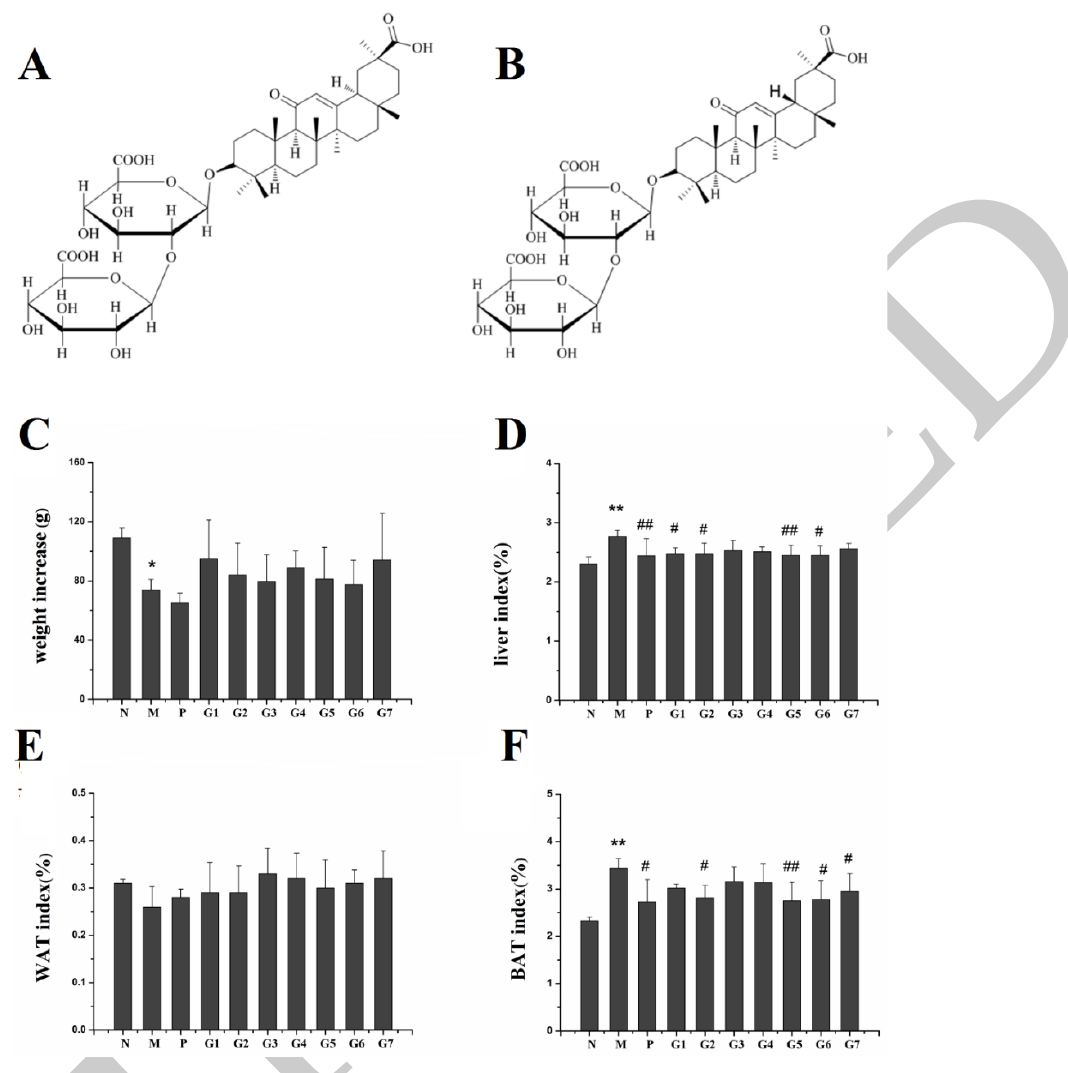
Figure 1. The chemical structure of 18α-GA ( A ) and 18β-GA ( B ); The effect of GA on body weight ( C );